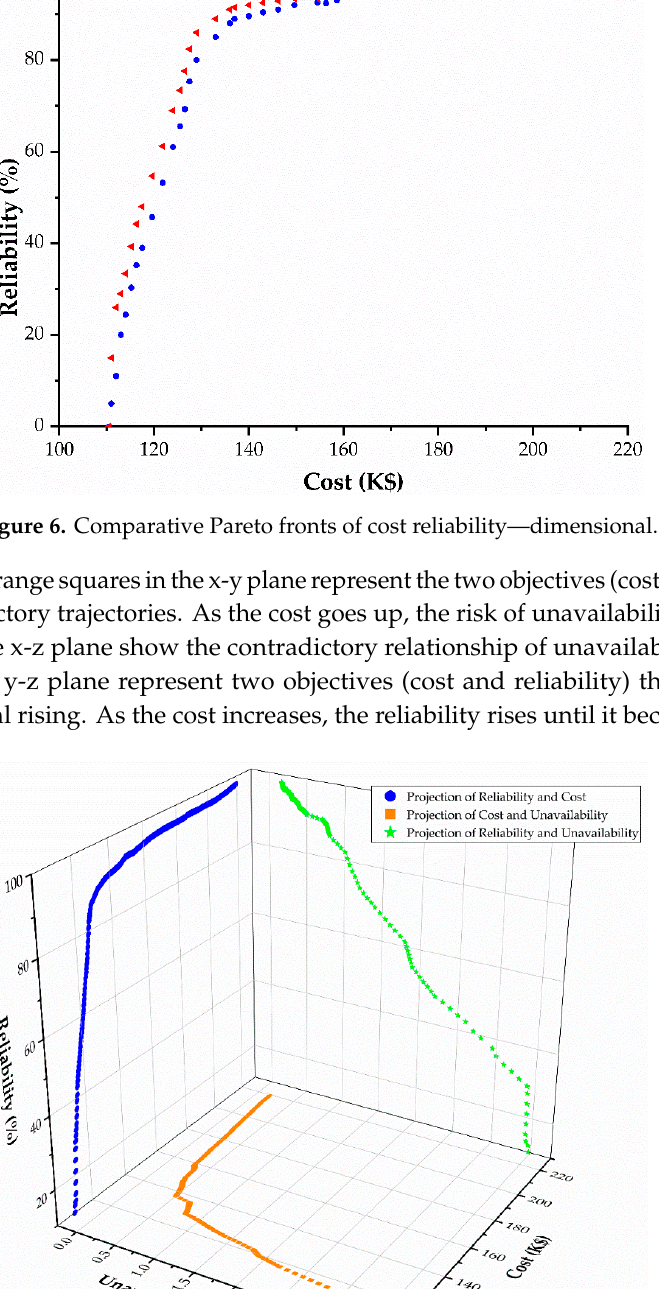
Figure 5. Comparative fitness of the three algorithms.